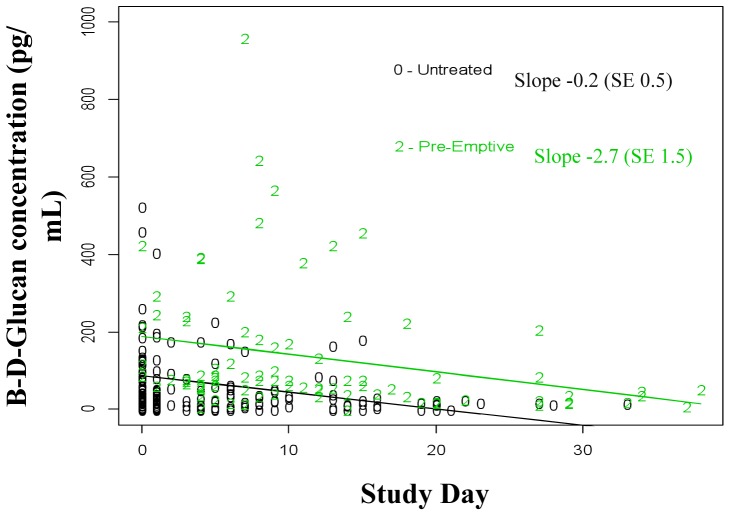
β-D-Glucan Concentrations Over Time in Subjects Receiving Preemptive versus No Antifungal Therapy.The antifungal treatment effect on glucan concentration over time was modeled as a linear trend. Abbreviations: 0 = subjects in the standard care group with at least one positive BDG test, but no systemic antifungal treatment; 2 = subjects in active surveillance group that were treated with preemptive anidulafungin; SE = standard error of the estimated glucan concentration slope.